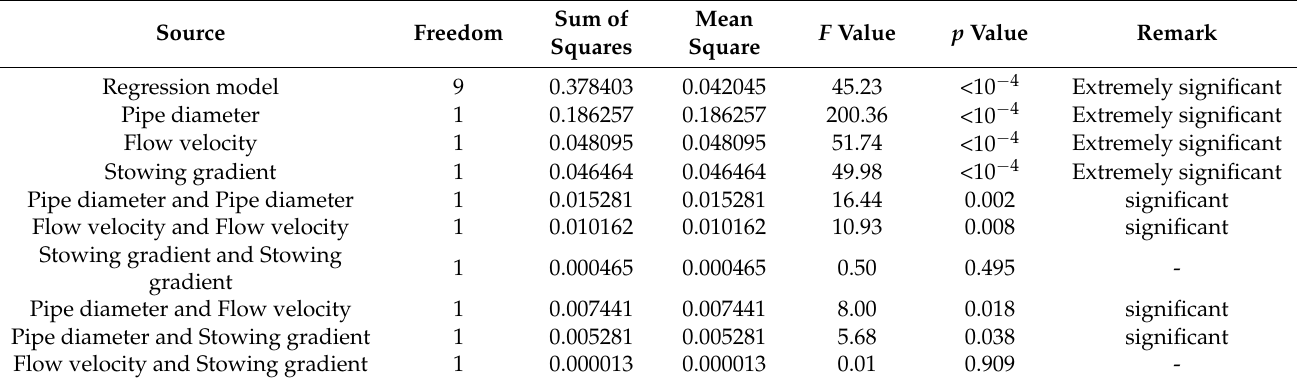
Table 11. Variance analysis of exogenous response surface